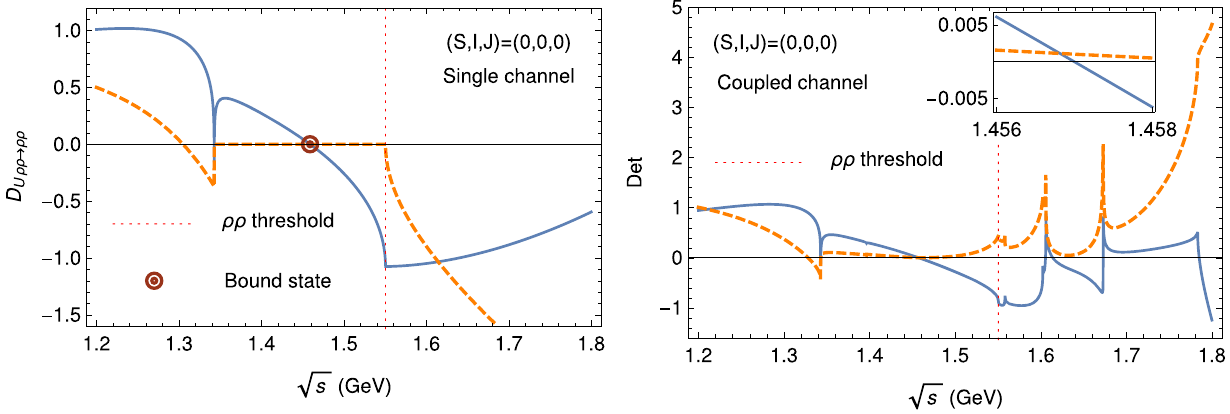
Fig. 3 The D U function and the determinant defined in Eq. (23) of the ( S , I , J ) = ( 0 , 0 , 0 ) unitarized amplitudes in Eq. (23) for the single channel ( ρρ ) and the coupled-channel cases evaluated with q max = 0 . 875 GeV (real part: solid curve, imaginary part: dashed